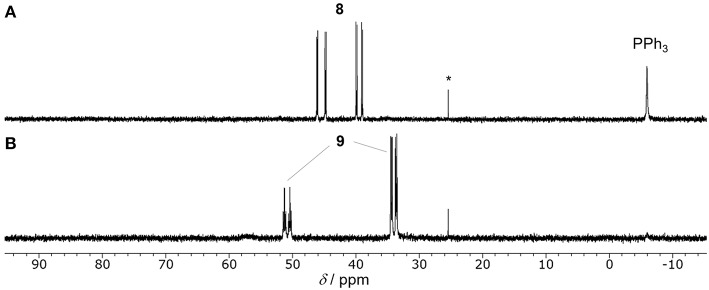
31P{1H} NMR spectra (202 MHz, DMA, −15°C) of the reactions of 8 under CO2 atmosphere in the presence of [Ru(bpy)3](PF6)2 (30 mol%) (A) after kept in dark, (B) after visible-light irradiation (λirr. = 425 nm) for 30 min. *(O=)PPh3.